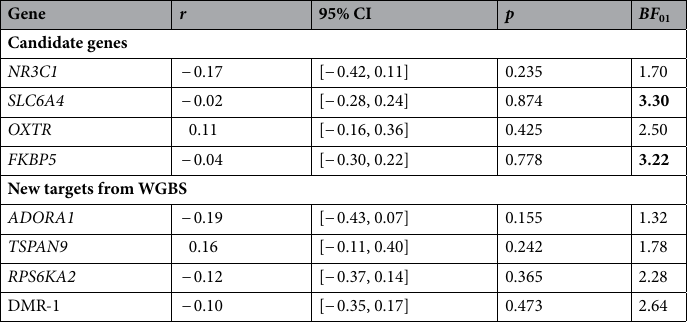
Table 2. Correlations between change in DNA methylation and change in symptom scores. r = Pearson’s correlation coefficient. 0 For NR3C1 , n = 53. For RPS6KA2 , n = 56. For all remaining genes, n = 57. BF 01 = Bayes factor quantifying the evidence for the null hypothesis against the alternative hypothesis. Bayes factor above 3 is interpreted as substantial evidence for the null hypothesis and shown in